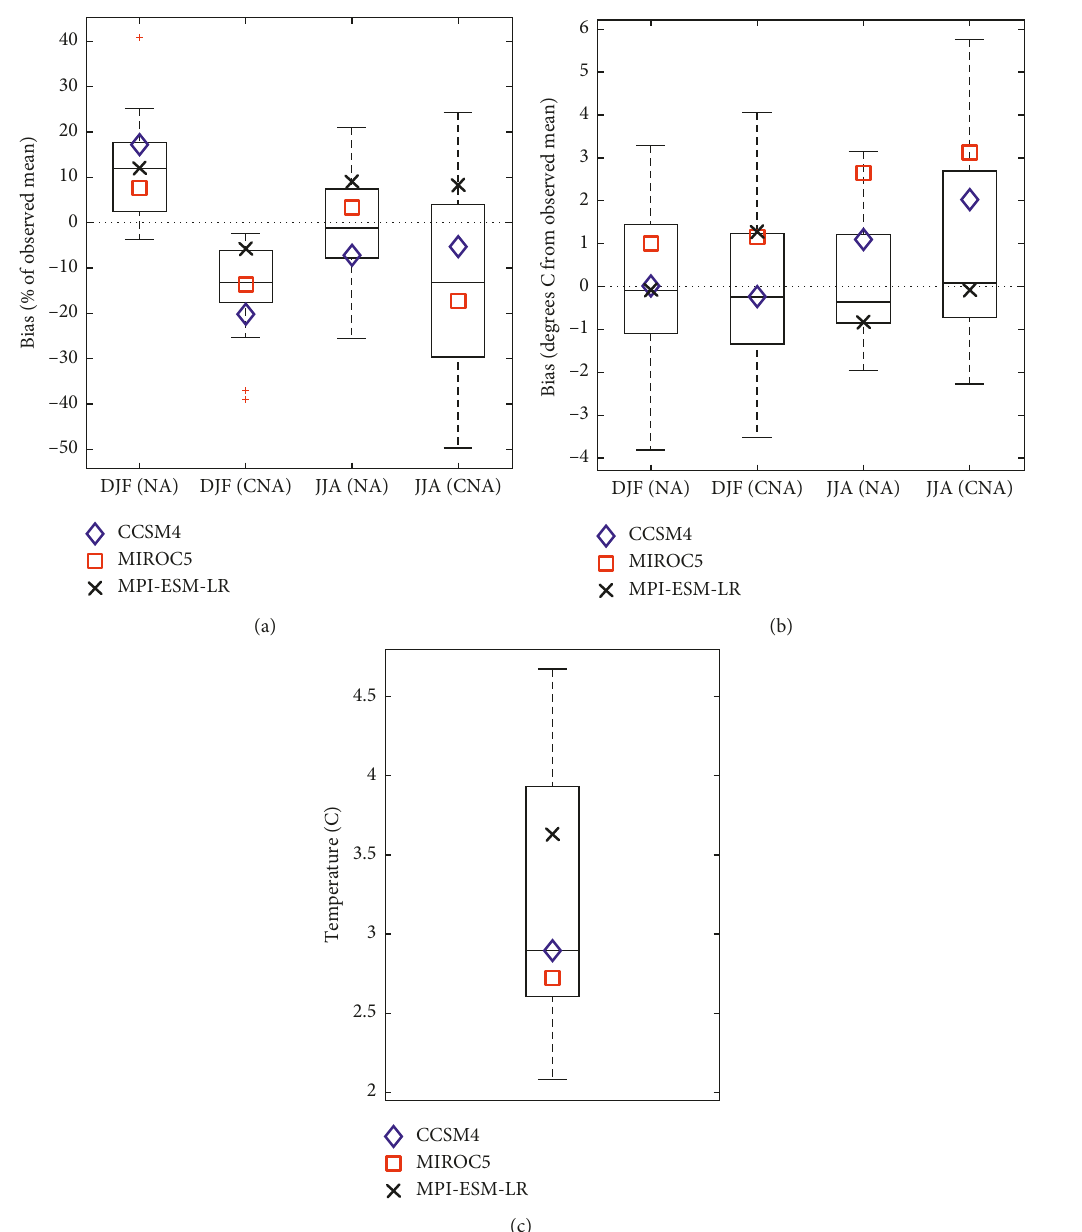
Figure 2: Performance assessment of the selected 3 GCMs (CCSM4, MIROC5, and MPI-ESM-LR) from the CMIP5 suite based on North American (NA) and central North American (CNA) winter (DJF) and summer (JJA) bias in (a) precipitation and (b) temperature, and (c) climate sensitivity (based on Sheffield et al. [30] and personal communication with Dr. Derek